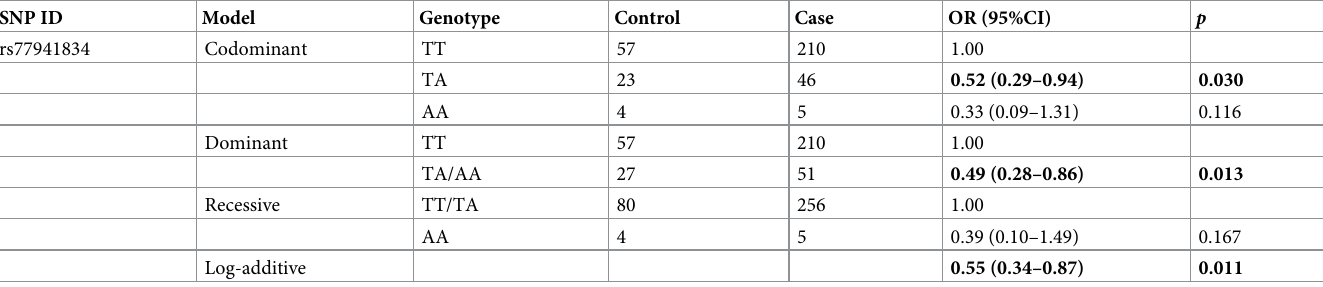
Table 4. Association between COL6A4P2 polymorphism and tumor staging of lung cancer.